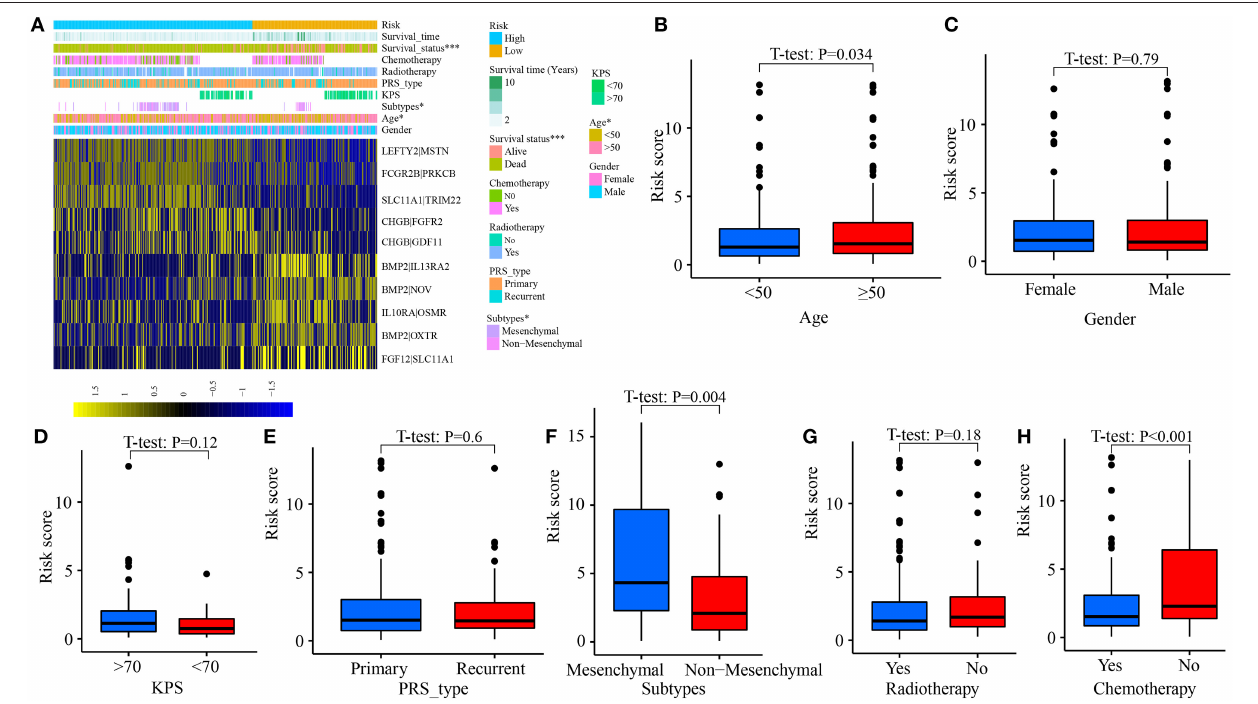
FIGURE 6 | Correlation between risk score and clinical characteristics. (A) Heat map for the distribution of clinicopathological features between high- and low-risk groups. (B) The difference of risk scores among patients aged < 50 and aged ≥ 50. (C) Between female and male. (D) Between patients with KPS ≤ 70 and > 70. (E) Between primary tumor and recurrent tumor. (F) Between different molecular subtypes. (G) Between patients with radiotherapy and without radiotherapy. (H) Between patients with chemotherapy and without chemotherapy. * p < 0.05, *** p <